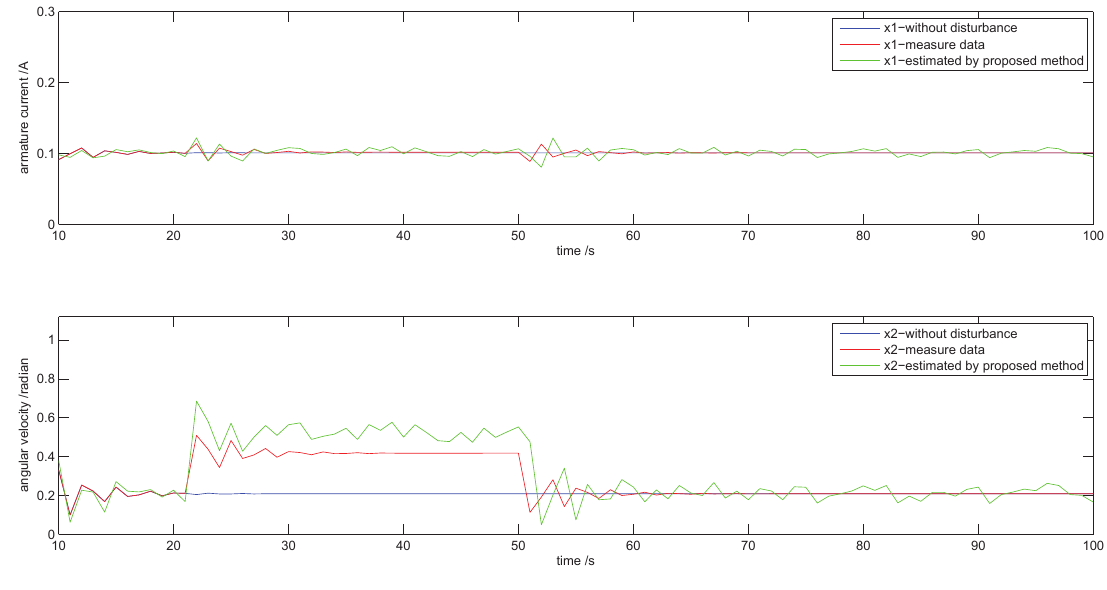
Figure 11. The evolution of states in